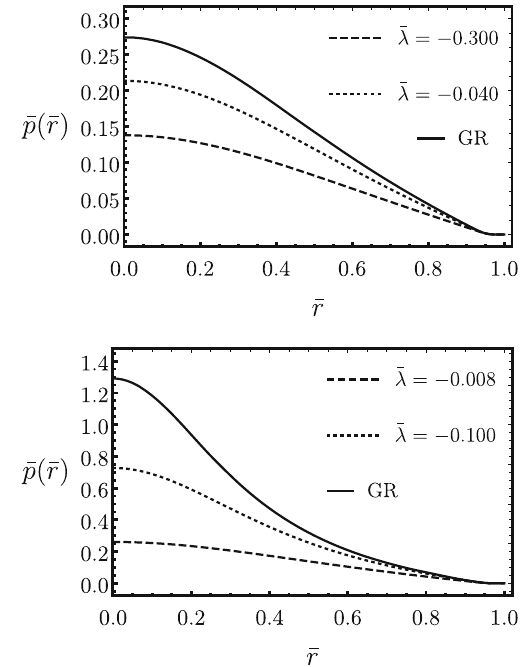
Fig. 10 ¯ m ( r ) as a function of ¯ r for different values of ¯ λ < 0 and ¯ ρ = 0 . 110 (upper panel), and ¯ ρ = 0 . 116 (lower 0 0